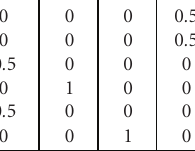
Figure 9: Reduced X . Table 2: Action list of The ICE. (c.f., top half part of Table 3) (c.f., bottom half of Table